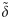
Trade-off between fast dissemination and efficient mixing described by the δ˜ model.(a) While the colony state (Pcolony, green) rises with the fraction δ˜ of transferred volume, mixing levels among non-foragers (which we call Hmix) decrease. The mixing levels over all ants in the colony (including the foragers) is the product of these two functions, Hmixoverall=Pcolony·Hmix and displays a broad maximum which spans all non-extreme values of δ˜. Curves can be compared to the empirically measured values (red bars) of the three experiments. (b) Standard deviation of individual mixing entropies hmixa across all ants. Standard deviations were calculated for 30 model runs. The plot depicts the mean and standard deviation of this value.